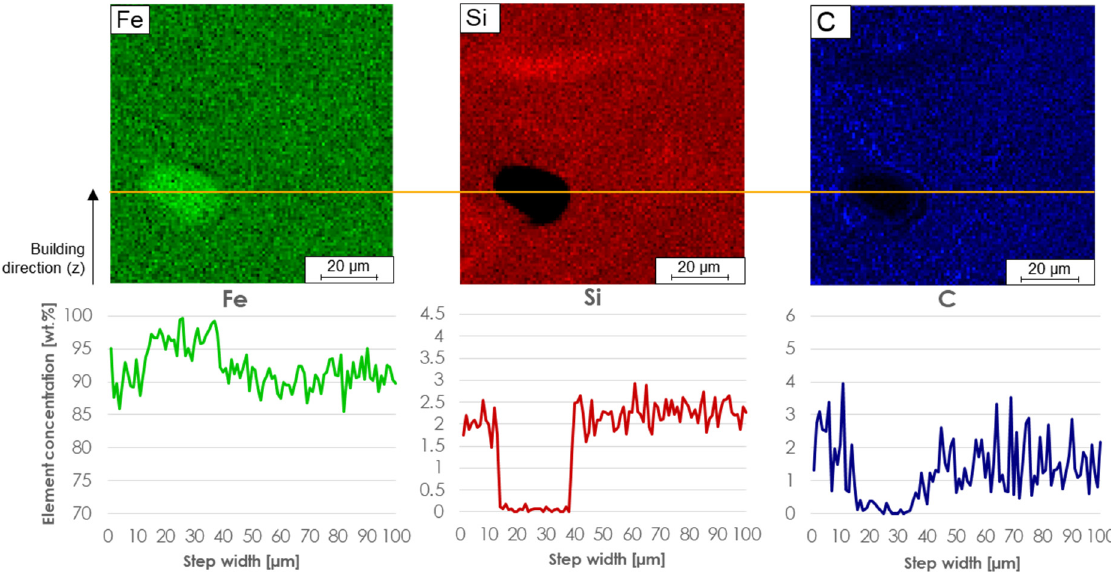
Figure 8. Microprobe results of an unmolten particle in M3* (measured line: orange).